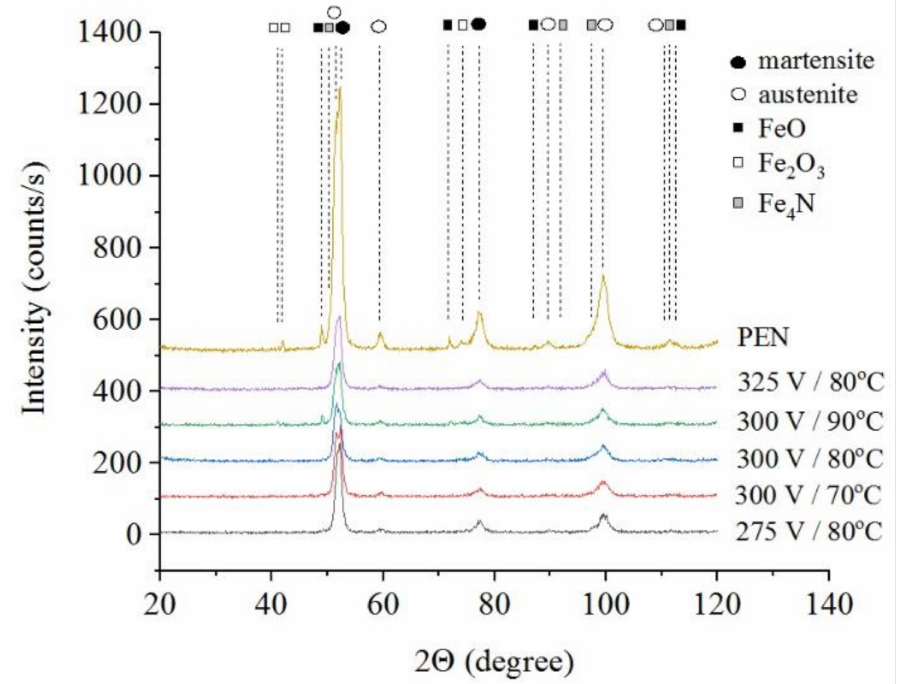
Figure 1. X-ray diffraction patterns of the steel surface layer after PEN in ammonium nitrate (5%) and ammonium chloride (15%) solution at 850 ◦ C for 5 min and subsequent PEP in ammonium sulfate (3%) solution at different voltages and temperatures of electrolyte under natural convection.